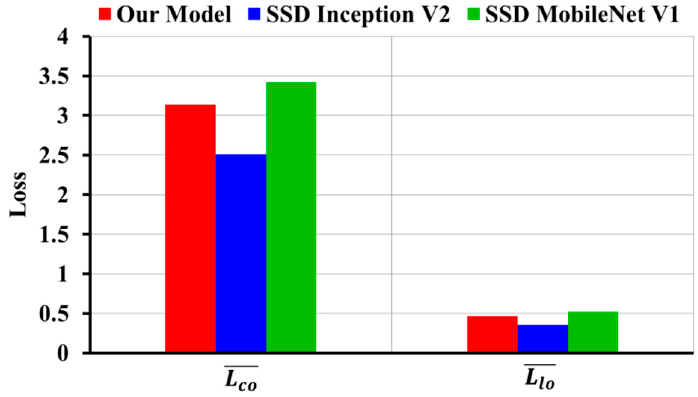
Figure 7. Comparison of classification and localization loss on image-wise testing set.